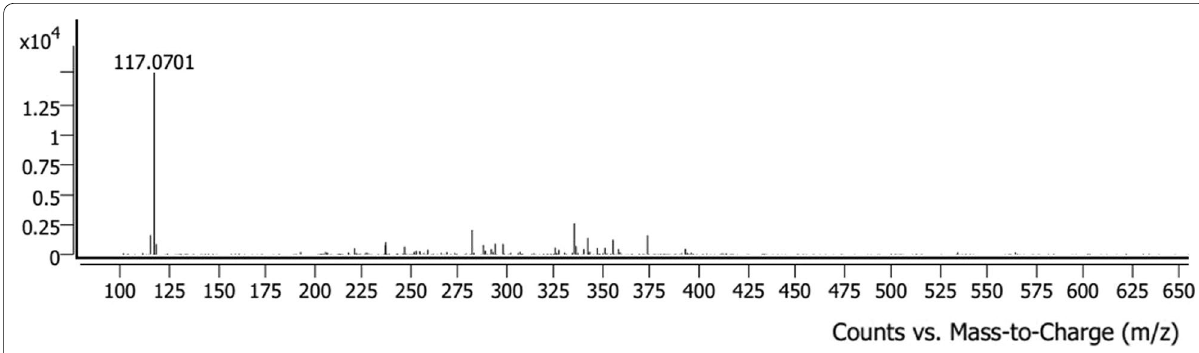
Fig.6 LC–MS spectra for DP1